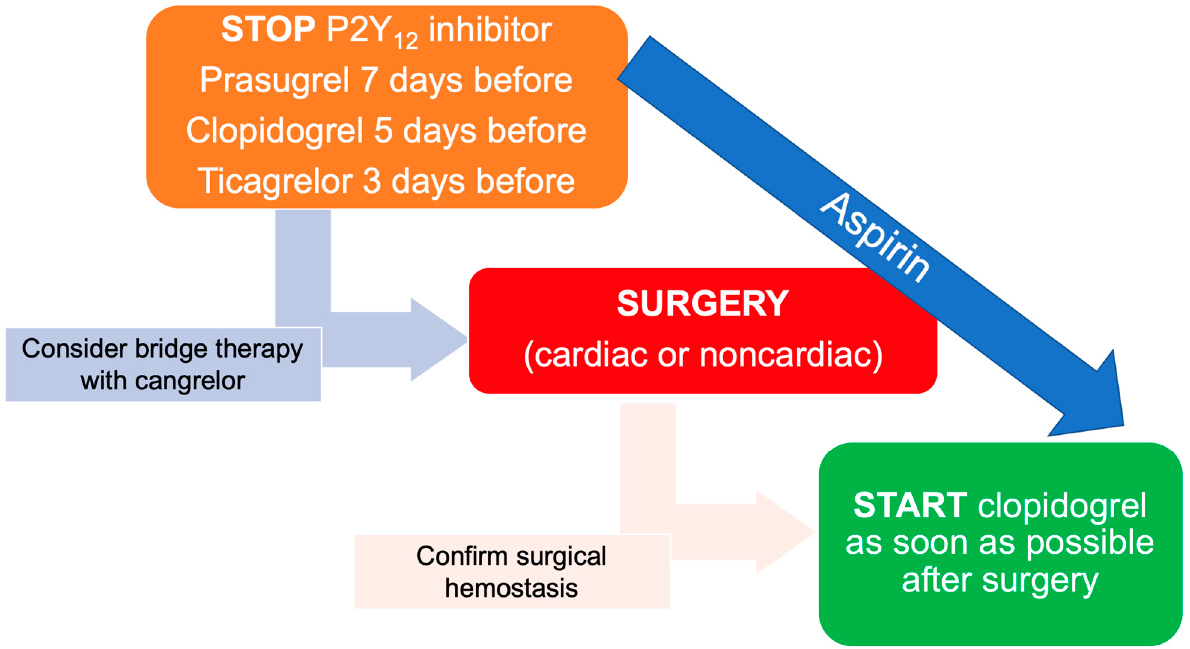
Figure 1. Time frames of P2Y 12 inhibitor discontinuation and restarting in patients undergoing cardiac or non-cardiac surgery. Elaborated from Valgimigli et al. [72] .